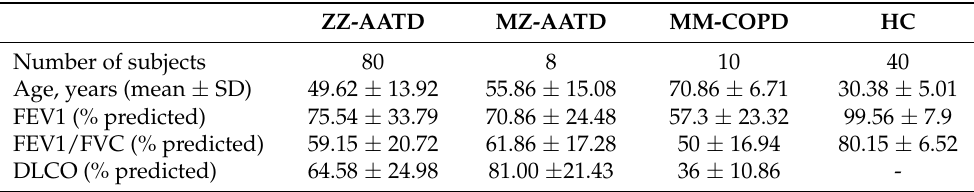
Table 1. Characteristics of healthy controls, ZZ-AATD and MM-COPD patients. ZZ-AATD